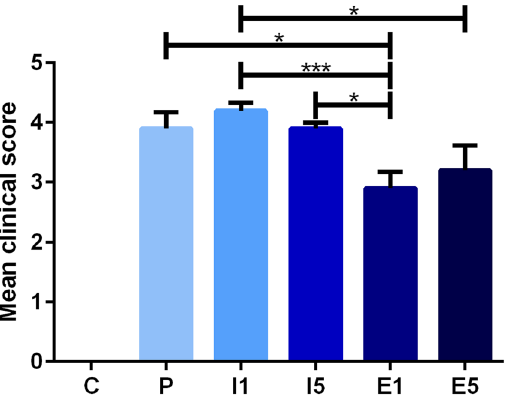
Figure 1. Mean clinical score for animals in the EAE model; control (C, n = 5), placebo (P, n = 10), IFN- β on day 1 (I1, n = 10), IFN- β on day 5 (I5, n = 10), etomoxir on day 1 (E1, n = 10) and etomoxir on day 5 (E5, n = 10). All data are presented as the mean ± SEM. Results from unpaired t-tests showed a statistically significant difference in the disease scores between E1 and I1, I5, and placebo. Treatment on E5 resulted in a significantly lower disease score than that on I1. Number of asterisks indicates level of statistical significance ( * p < 0.05 and *** p < 0.001).